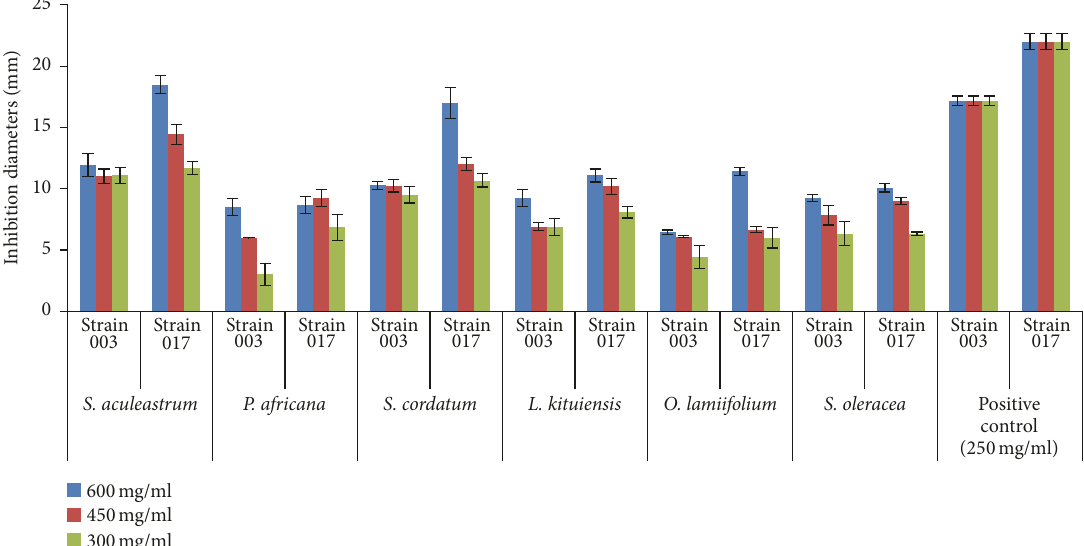
Figure1:Comparisonofinhibitionof A.flavus UONV017andthatof A.flavus UONV003byorganicplantextractsatdifferentconcentrations.